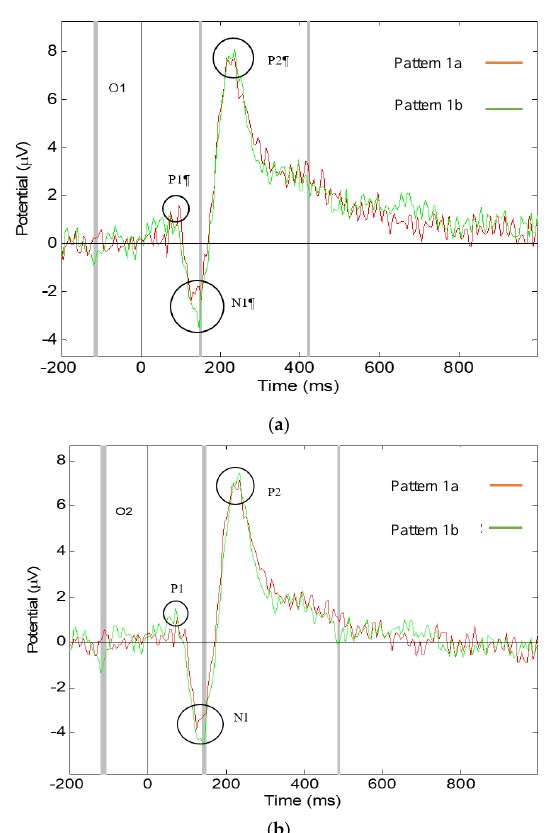
Figure 9. Grand average ERP responding to Pattern 1a,b, the grey lines show the significant difference with p -value < 0.05: ( a ) measured at O1 electrode channel; ( b ) measured at O2 electrode channel. Table 1. Amplitude and latency di ff erences of N and P components of visual ERP waves evoked by Pattern 1a,b O1 Electrode